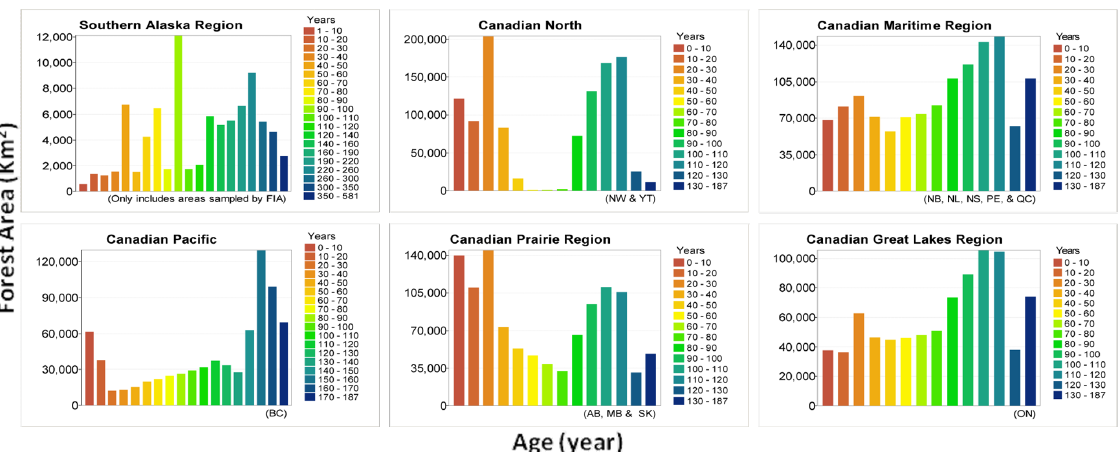
Fig. 5. Forest age distributions of the Southern Alaska of the US and regions of Canada (the histograms are placed in this figure as much as possible corresponding to their geographical positions)